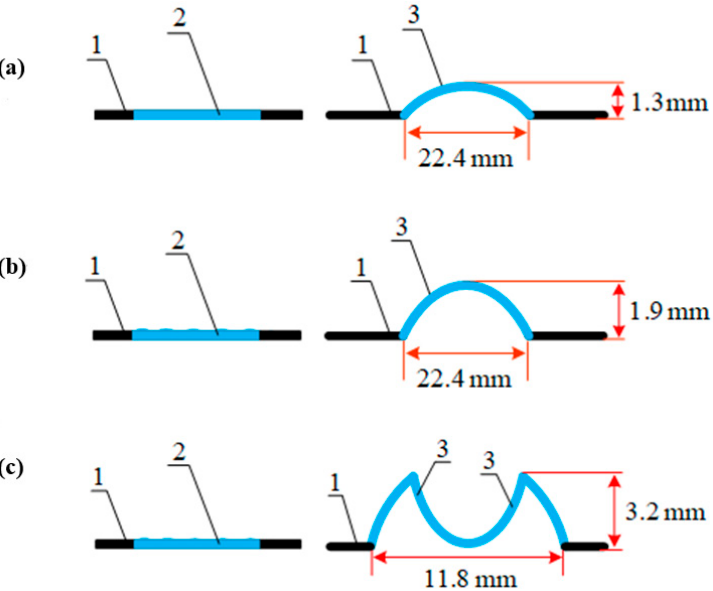
Figure 7. Section of a label made of an SMP film treated with a 30% THF solution before and after